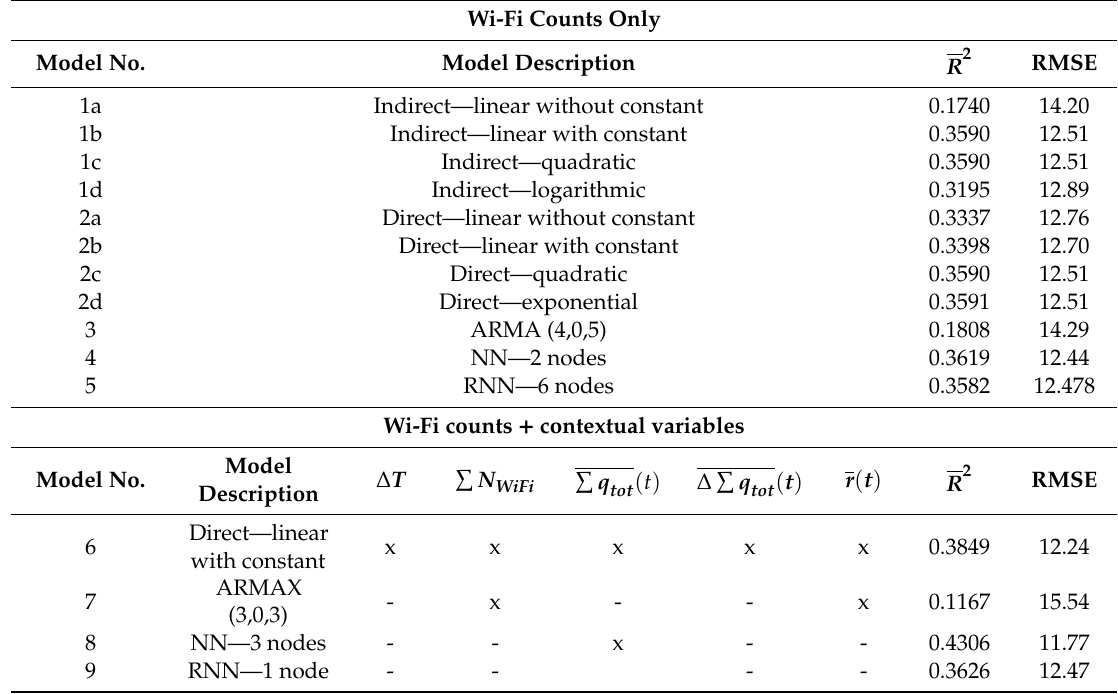
Table 4. Summary of model estimation results, where the bold model is the best model. For all models, 2 the R and RMSE are depicted for the Thursday and Saturday time